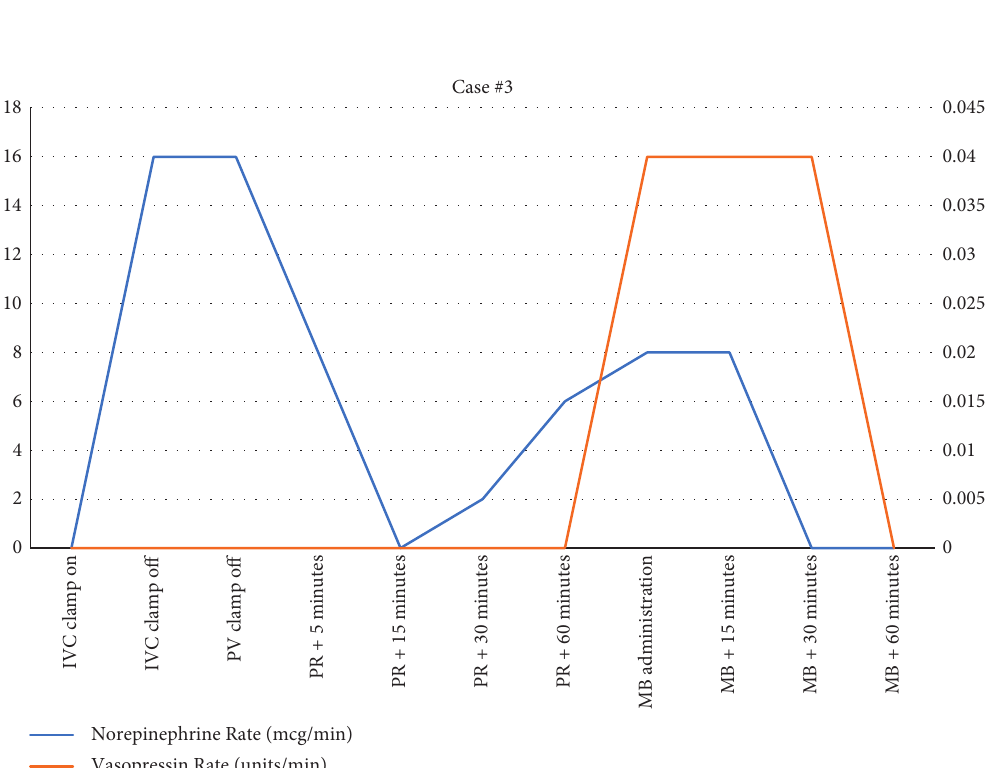
Figure 6: Vasoactive medication use during case